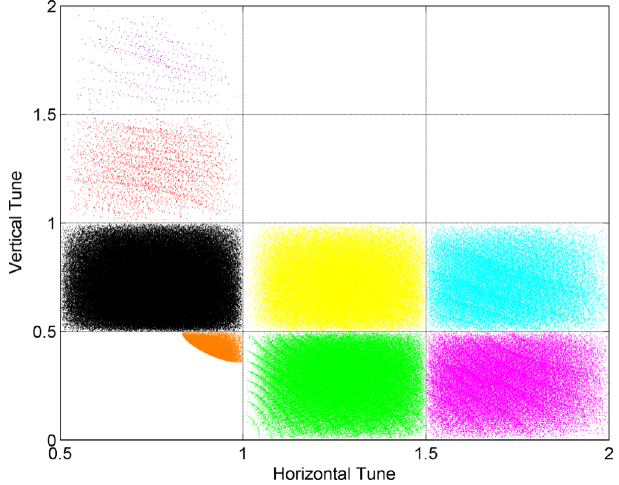
FIG. 5. (Color) All stable solutions plotted in tune space for one of the 12 ALS TBA sectors. Note the nominal ALS sector tune is (1.19, 0.77). Each of the half-integer-square regions in tune space is given a distinct color.